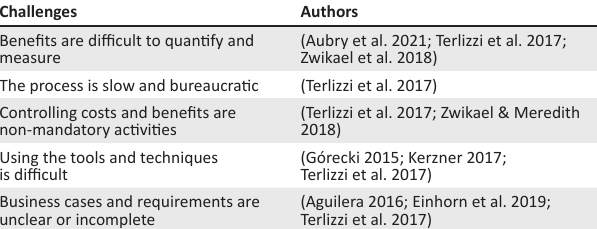
TABLE 2: Benefits realisation management